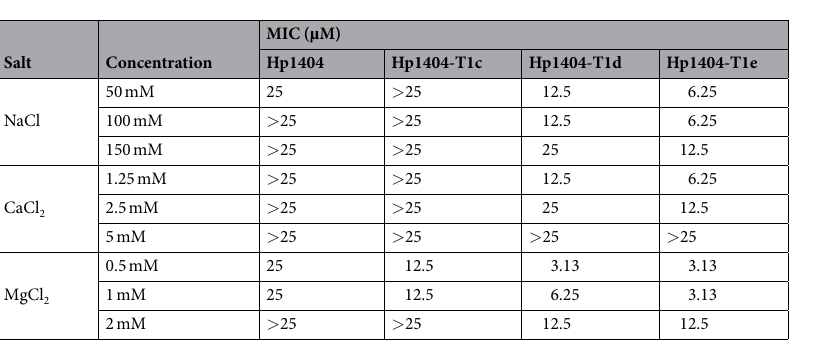
Table 3. Antibacterial activities of synthetic peptides against P. aeruginosa 27853 under conditions mimicking physiological concentrations of